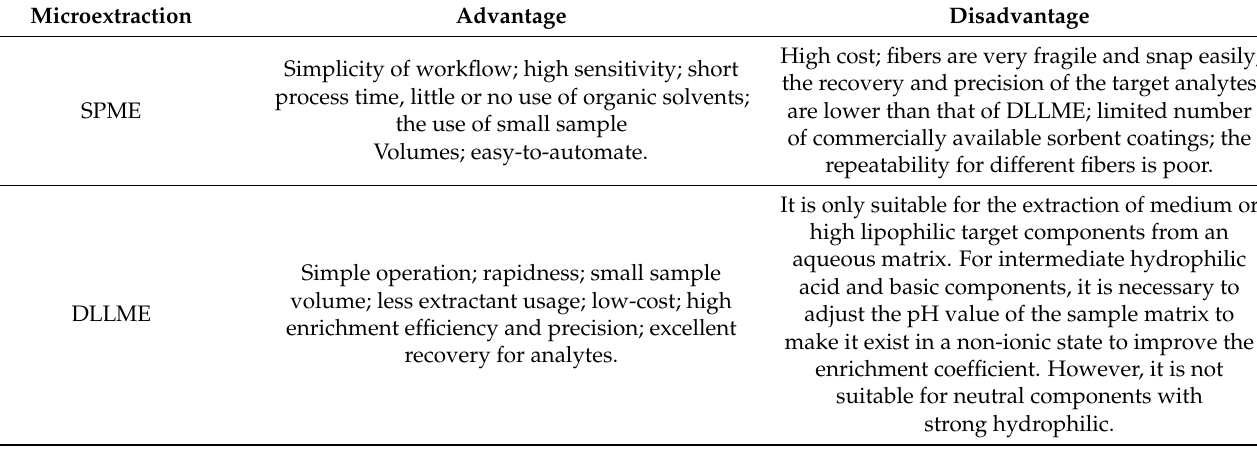
Table 3. Advantages and disadvantages of SPME and